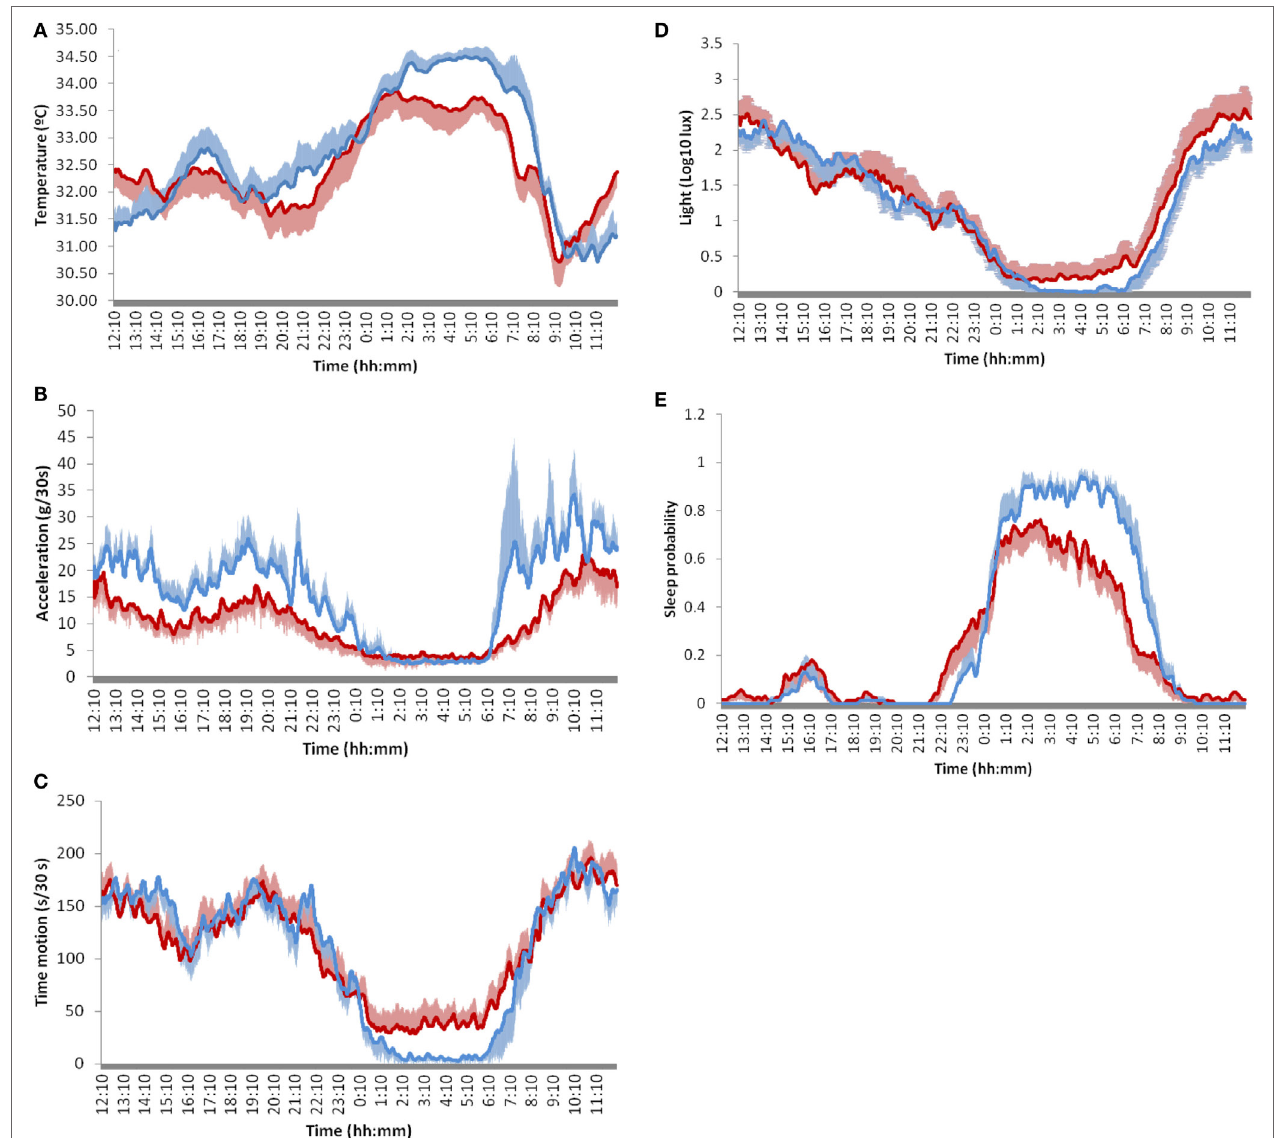
FigUre 3 | Twenty-four-hour mean waveforms of selected circadian variables in Parkinson’s disease patients (red line) and controls (blue line). (a) skin temperature, (B) acceleration, (c) movement duration, (D) light exposure, and (e) sleep probability. Values are represented as the mean ± SEM of 12 subjects for each condition recorded every 30 s during 7